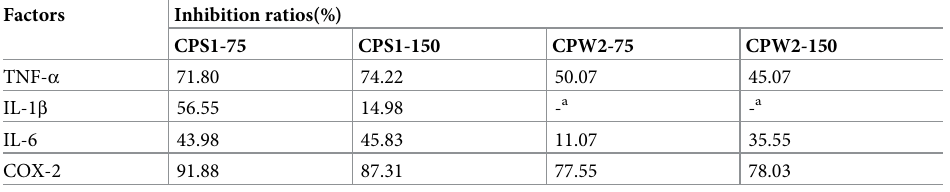
Table 2. Inhibition effects of CPS1 of CPW2 on the expression of inflammatory factors in LPS-stimulated RAW264.7 cells.